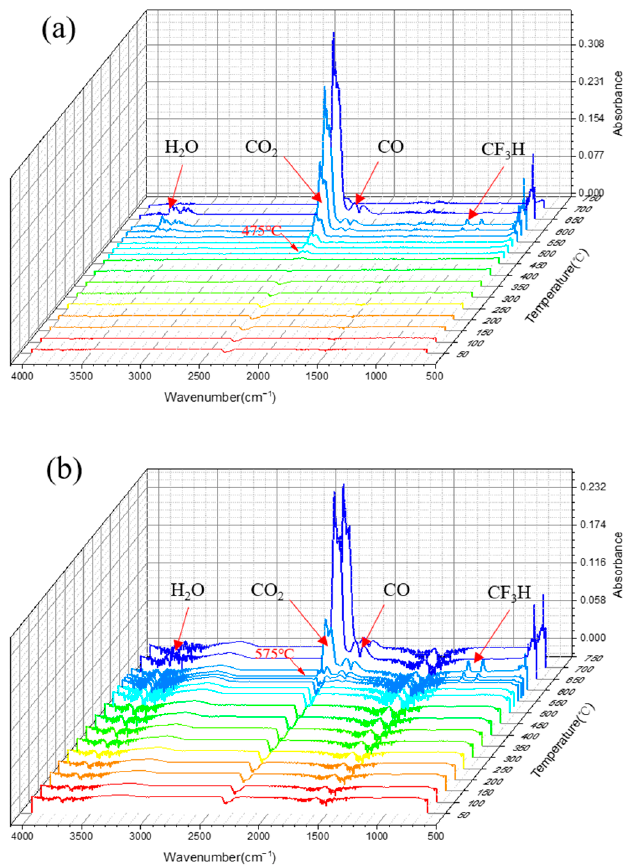
Figure 9. The release of degradation products was examined by TGA-FTIR at different temperatures: ( a ) control and ( b ) 0.4% Nd 2 O 3 .